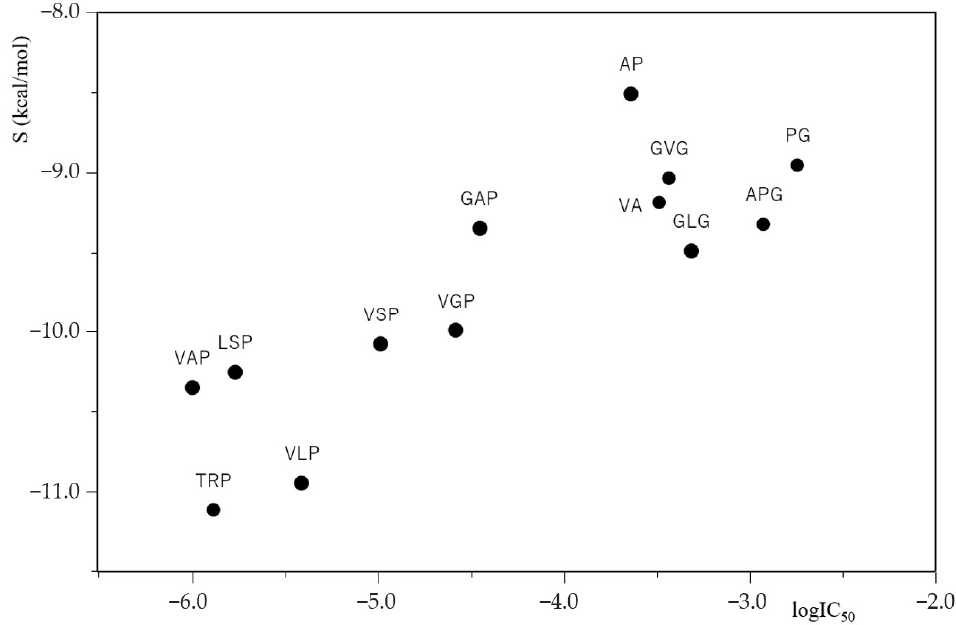
Figure 1. A plot of logIC 50 of ACE inhibitory peptides against docking score S between ACE inhibitory peptides and ACE (PDB ID code: 1O8A).